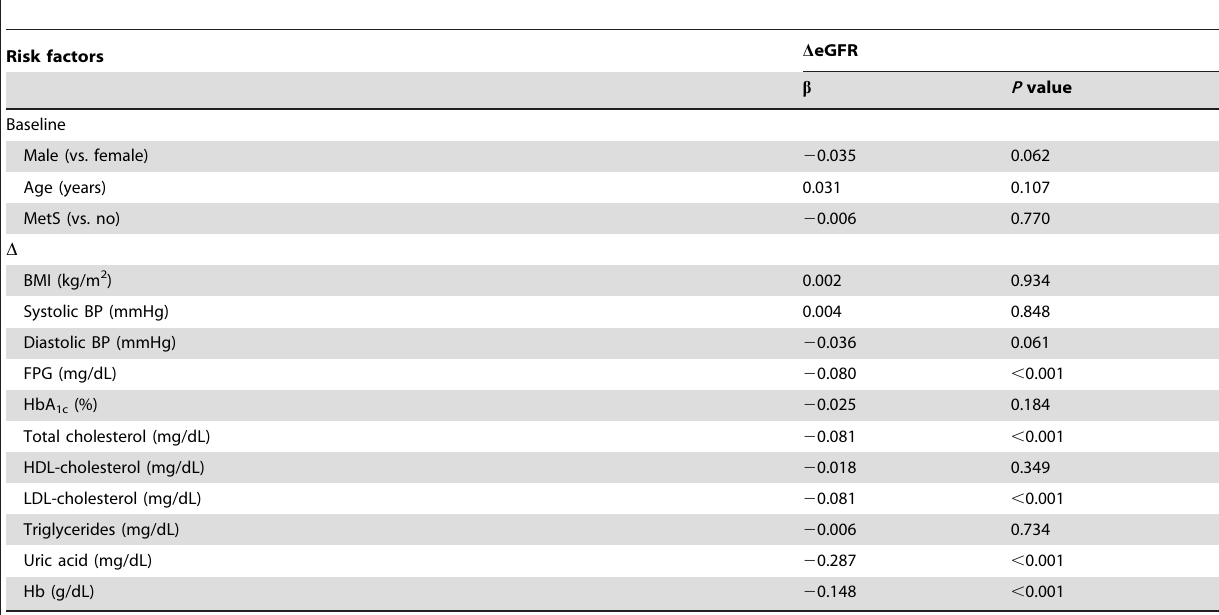
Table 2. Simple linear regression analysis of factors related to D